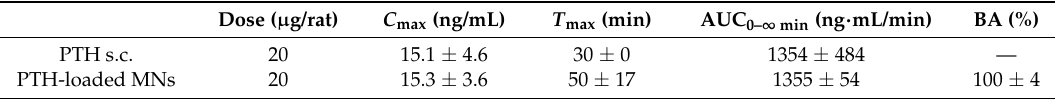
s.c., subcutaneous injection; AUC, area under the plasma concentration-time curve; BA,